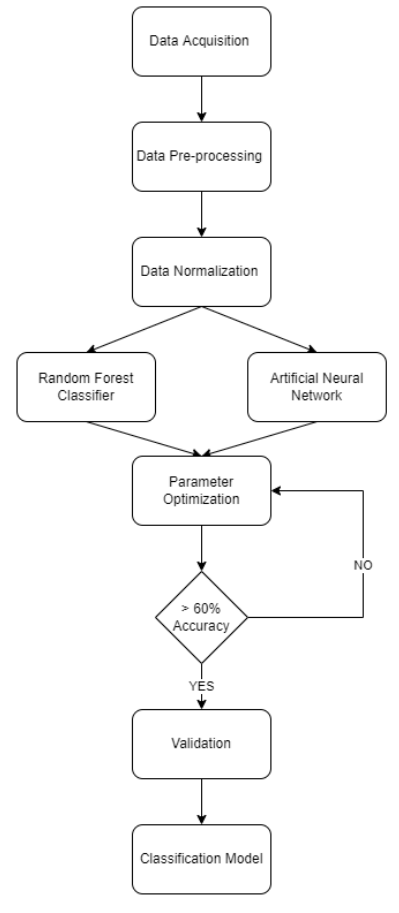
Figure 2. Methodological Flowchart.